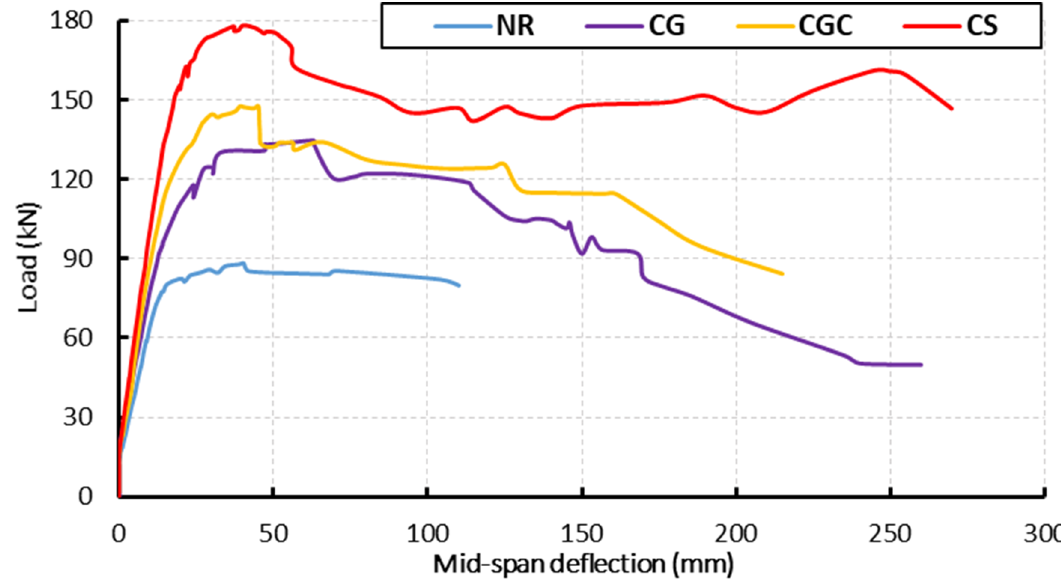
Figure 5. Load ‐ deflection relationships for the tested specimens under static loads. Figure 5. Load-deflection relationships for the tested specimens under static loads.